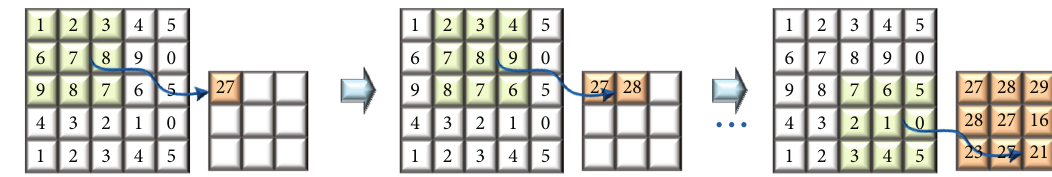
Figure. 2: Schematic diagram of the convolution